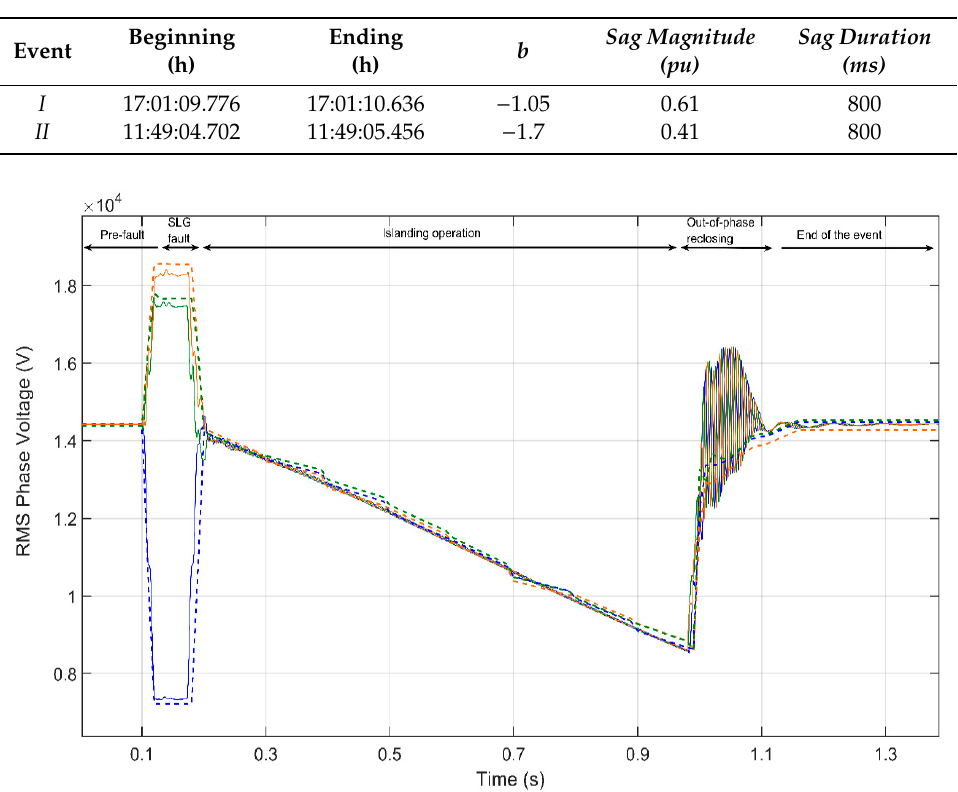
Table 3. Voltage sags characteristic summary for Events I and II .